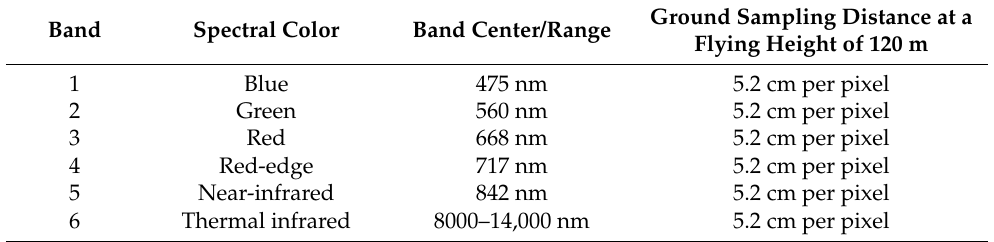
Figure 3. ( a ) DJI Matrice 300 platform, and ( b ) MicaSense Altum multispectral-thermal camera. Table 2. MicaSense Altum camera specifications.